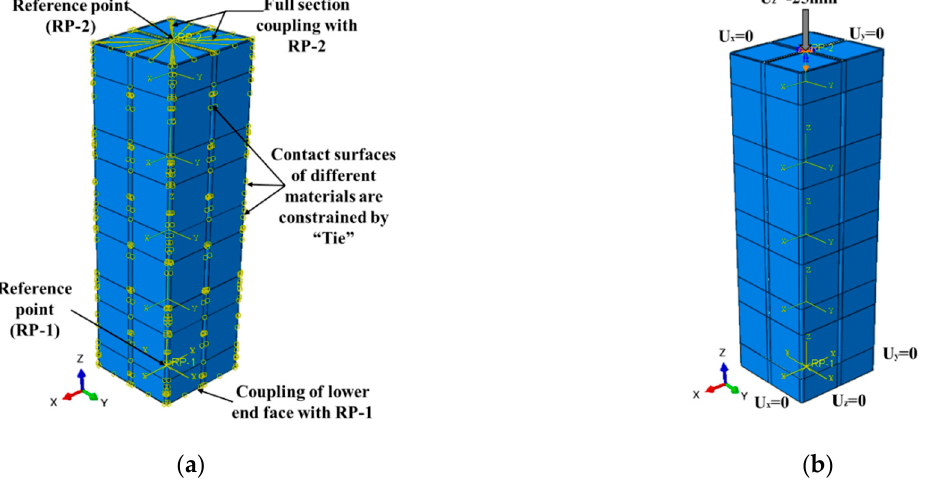
Figure 7. Numerical model: ( a ) Interaction of Numerical Models; ( b ) Boundary conditions of numerical model.